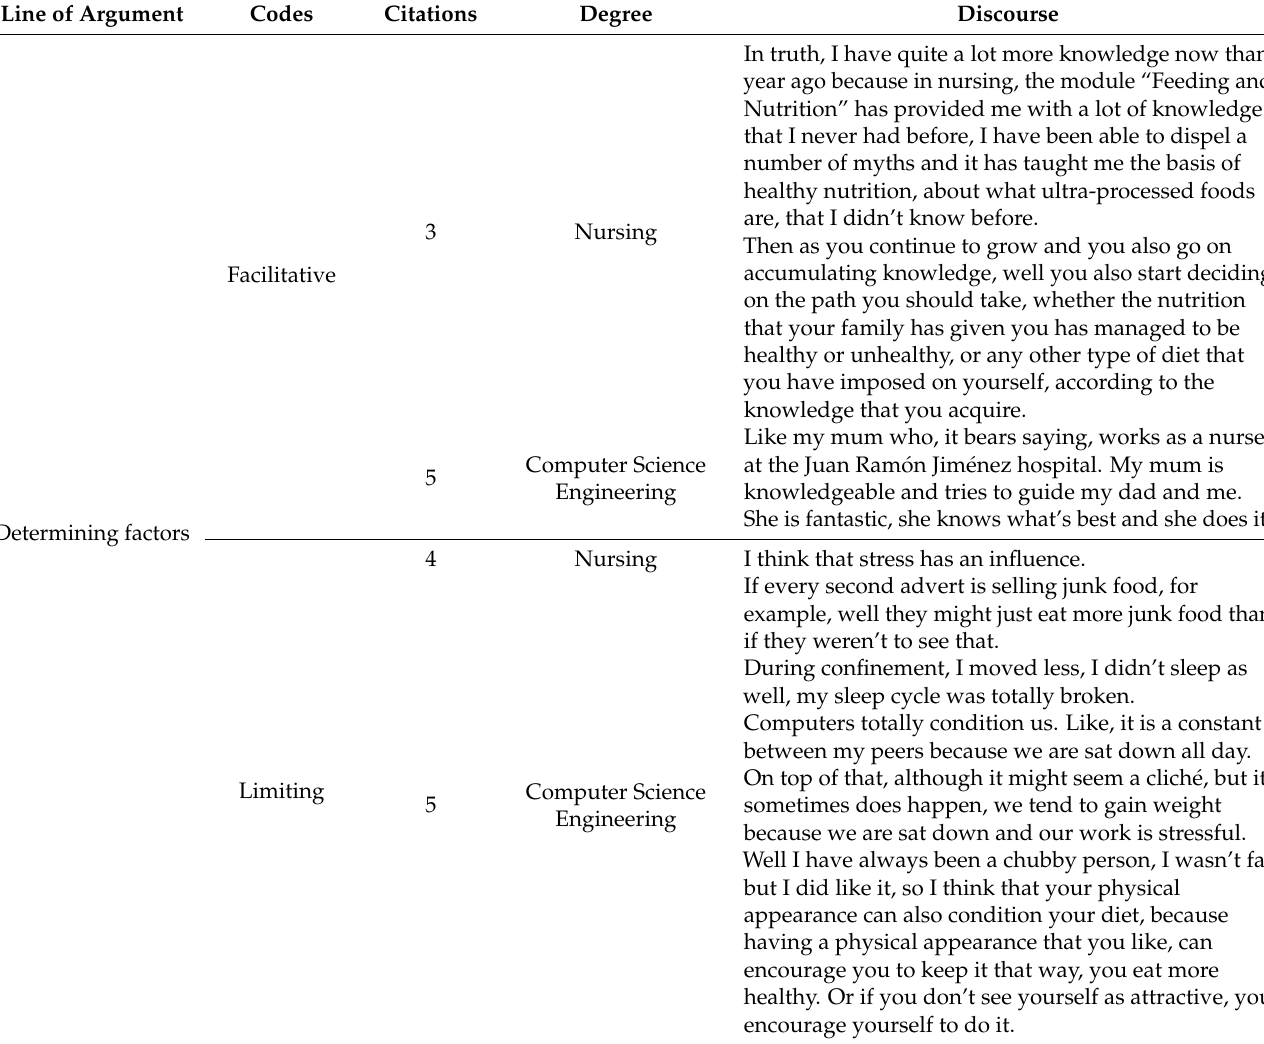
Table 6. Codes and nursing and engineering student discourse. Facilitating and limiting